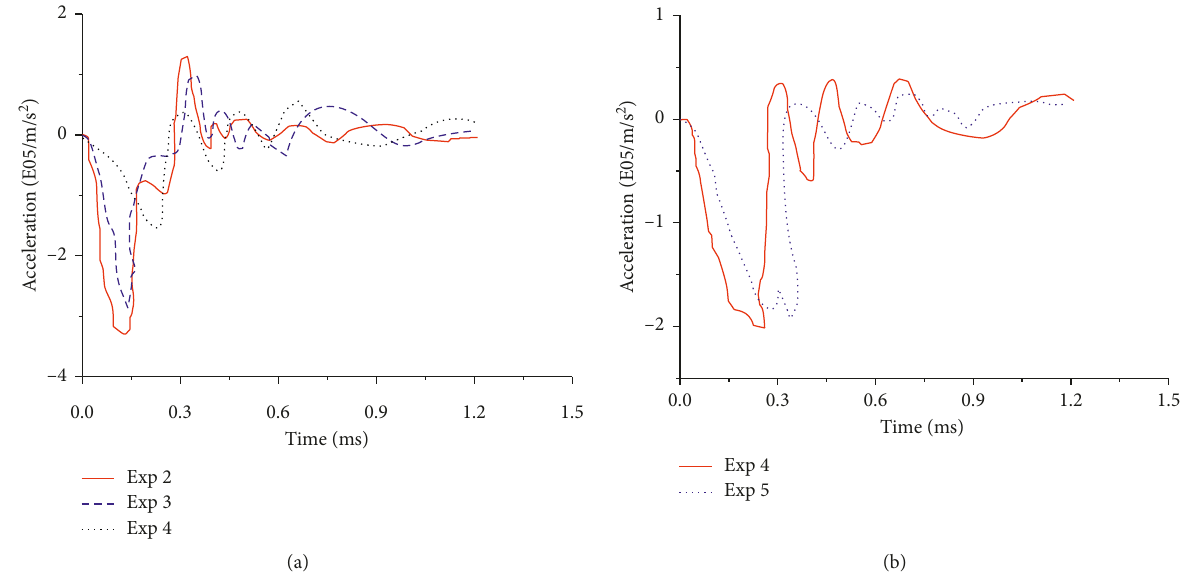
Figure 22: Test acceleration curves from the bottom of the bottom plates. (a) Tests 2, 3, and 4. (b) Tests 4 and 5.